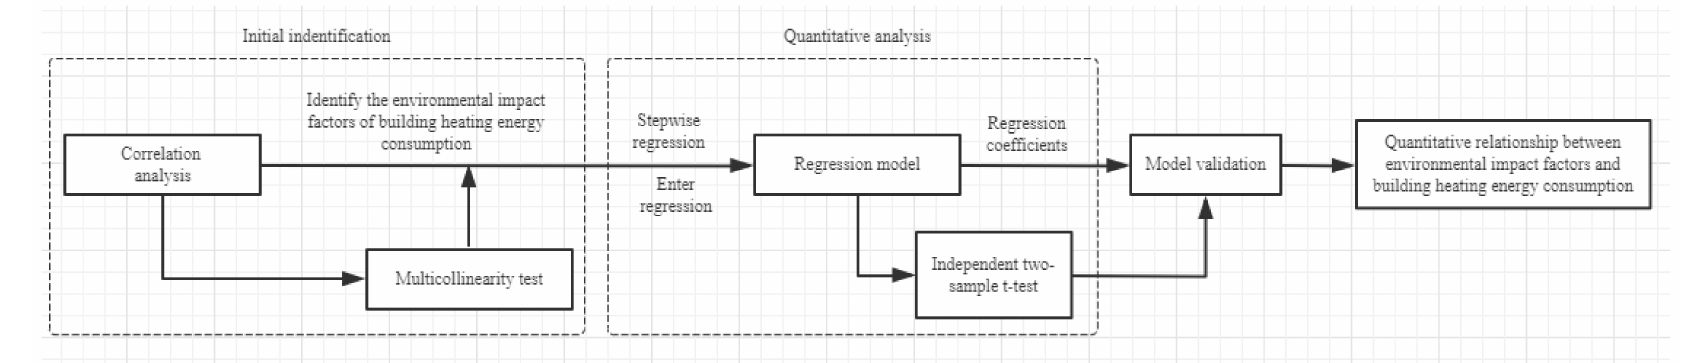
Figure 5. Statistical analysis